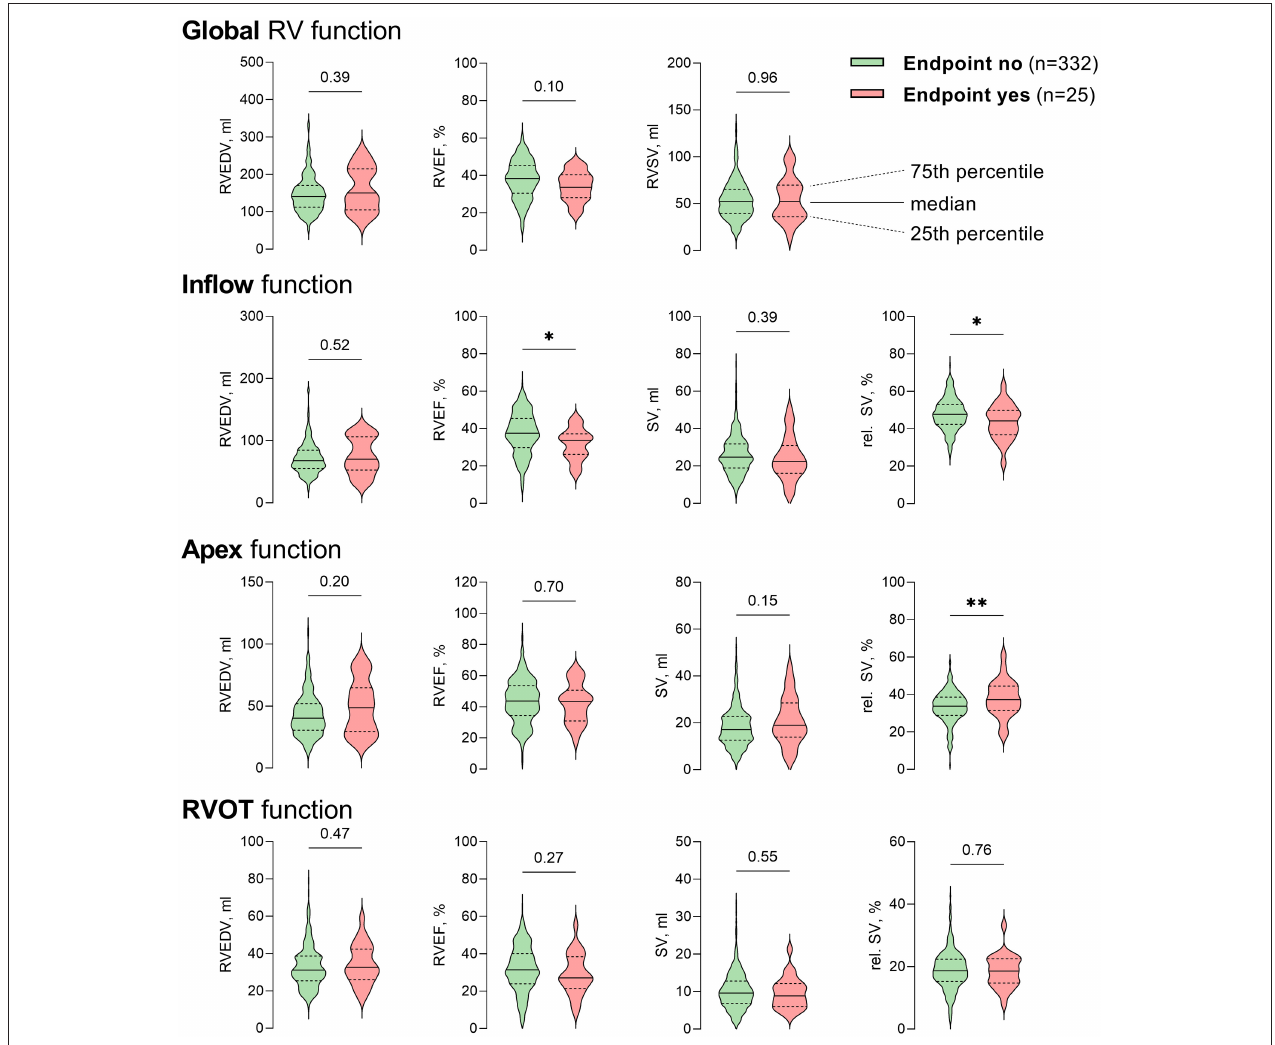
FIGURE 1 | Violin plots of global and regional RV volumetry parameters using 3D-STE-derived mesh models. Global RV function of patients who reached the endpoint (red) did not differ significantly from patients with an uncomplicated postoperative course (green). However, patients who died postoperatively or required extracorporeal circulatory support had lower inflow ejection fraction and inflow relative stroke volume, while relative stroke volume of the apex was significantly higher. P -values are derived from unpaired Student’s t -tests. Rel., relative; RVEDV, right ventricular end-diastolic volume; RVEF, right ventricular ejection fraction; STE, speckle-tracking echocardiography; (RV)SV, (right ventricular) stroke volume; * p < 0.05; ** p <